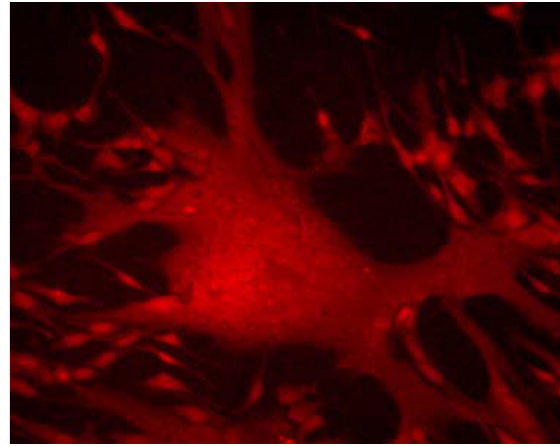
Fig. 2 Giant cells formed through the fusion of host cells in TV line. PI fluorescent staining × 200.